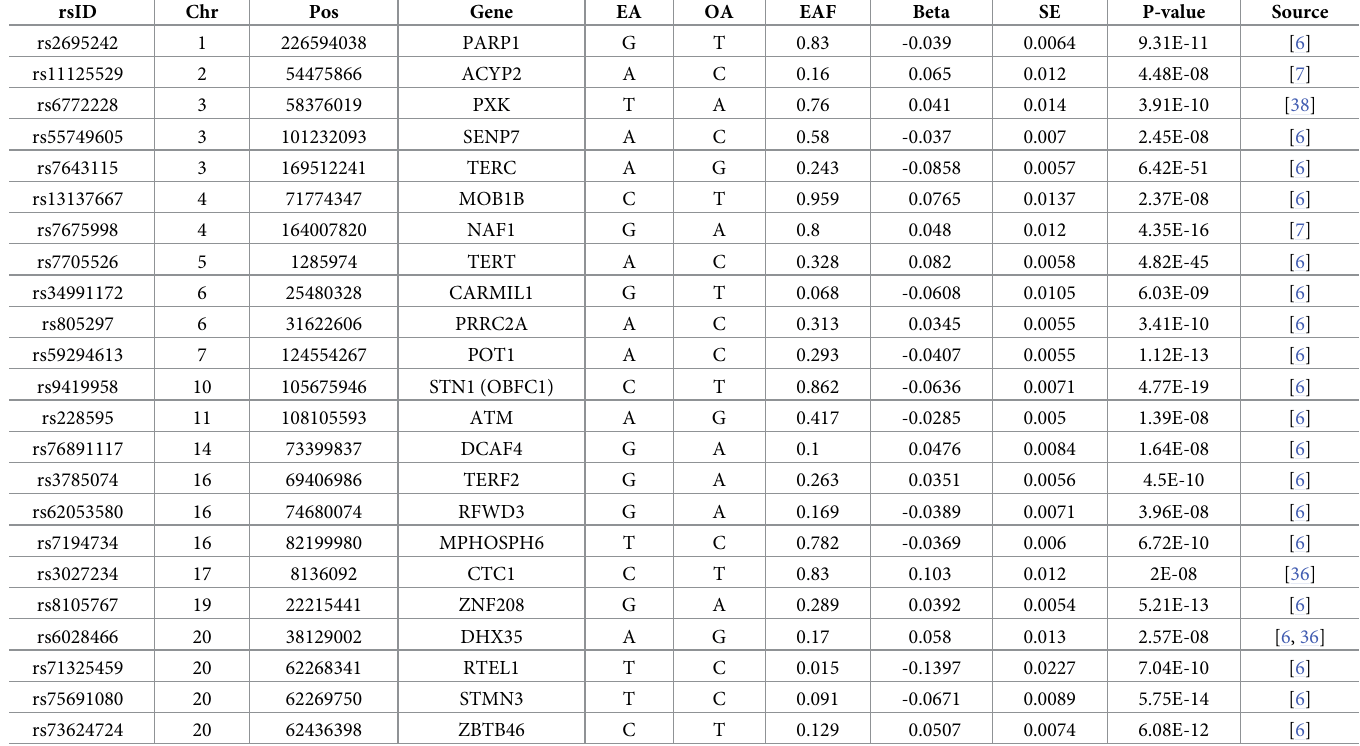
Table 2. List of the SNPs used in the MR analysis. rsID, ID of the SNP; Chr, chromosome; Pos, position of the SNP in the genome; EA, effect allele; OA, other allele; EAF, effect allele frequency; Beta, beta value of the SNP in GWAS; SE, standard